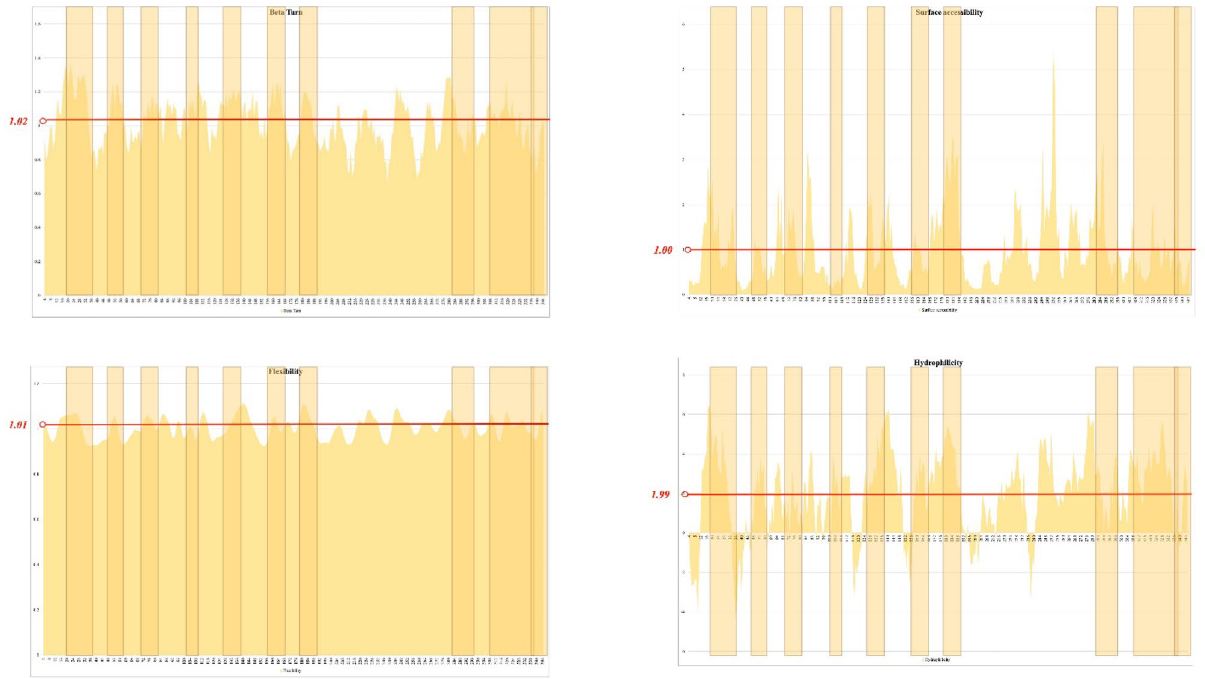
Figure 5. Physicochemical properties of the designed construct. Four physicochemical properties of the selected region of spike glycoprotein in favor of B-cell epitope propensity are presented by histograms. The selected regions in each histogram are shown by light brown transplant boxes; each graph is labeled by the related property. The average flexibility, hydrophilicity, and beta-turn secondary structure of the designed construct were 1.005, 1.991, and 1.023 respectively. X-axes are the amino acid number and Y-axes are the score of the related